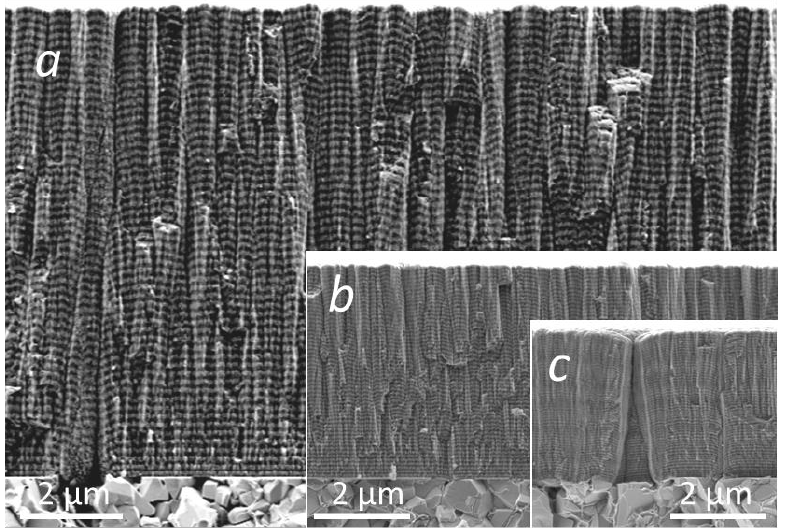
Figure 1. Fracture cross-sectional SEM images of NL-TiAlN/CrN hard coating sputter deposited on cemented carbide substrates. The samples were prepared in the same batch but rotated around a different number of axes: ( a ) one-fold, ( b ) two-fold and ( c ) three-fold rotation. The magnification scales are identical.